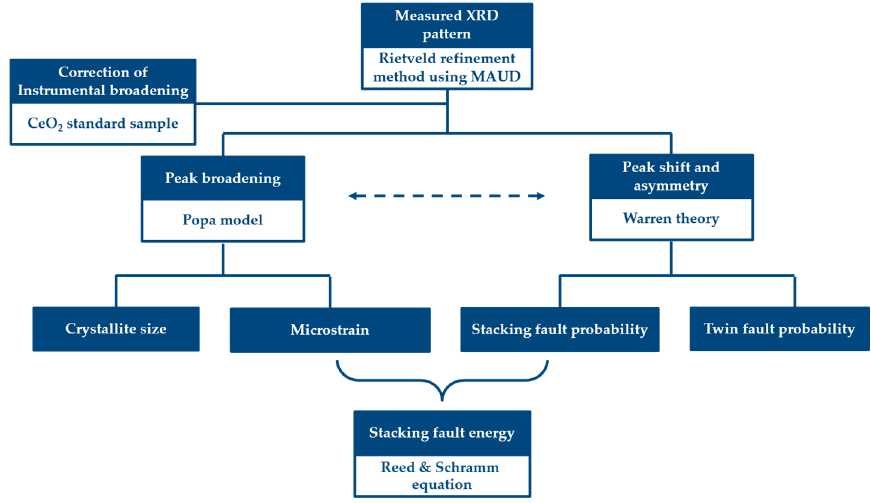
Figure 3. The flow chart of the SYXRD profile-analysis procedures.